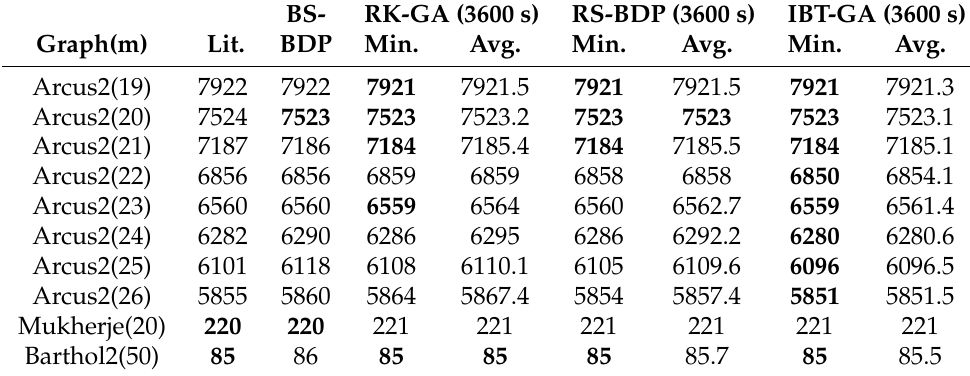
Table 3. Individual results of the algorithms for the hard instances of the reference set (instances in which the best solution of any of the proposed methods in any of its executions differs from the previous best-known solution in the literature). For each instance, defined by graph name and number of stations (m), the solutions found in the literature (Lit), and the solutions provided by each of the proposed methods are reported. The minimum and average value out of 10 executions are reported for the RK-GA, RS-BDP, and IBT-GA methods. Best-known solutions are indicated in boldface. BS- RK-GA (3600 s) RS-BDP (3600 s) IBT-GA (3600 s) Graph(m) Lit. BDP Min. Avg. Min. Avg. Min.